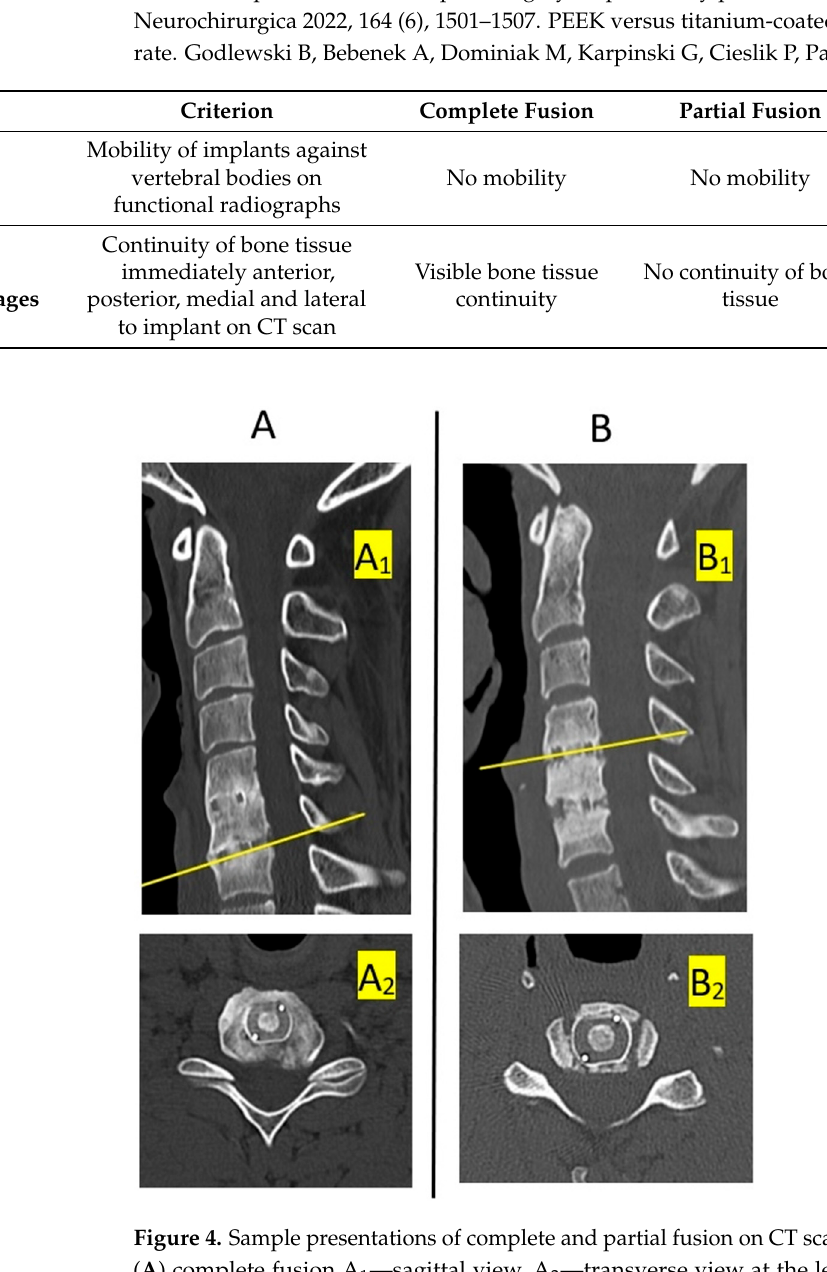
Table 1. Criteria for evaluation of fusion based on CT scans and functional conventional radiographs of cervical spine at 12 months post-surgery. Reprinted by permission from Springer Nature: Acta Neurochirurgica 2022, 164 (6), 1501–1507. PEEK versus titanium-coated PEEK cervical